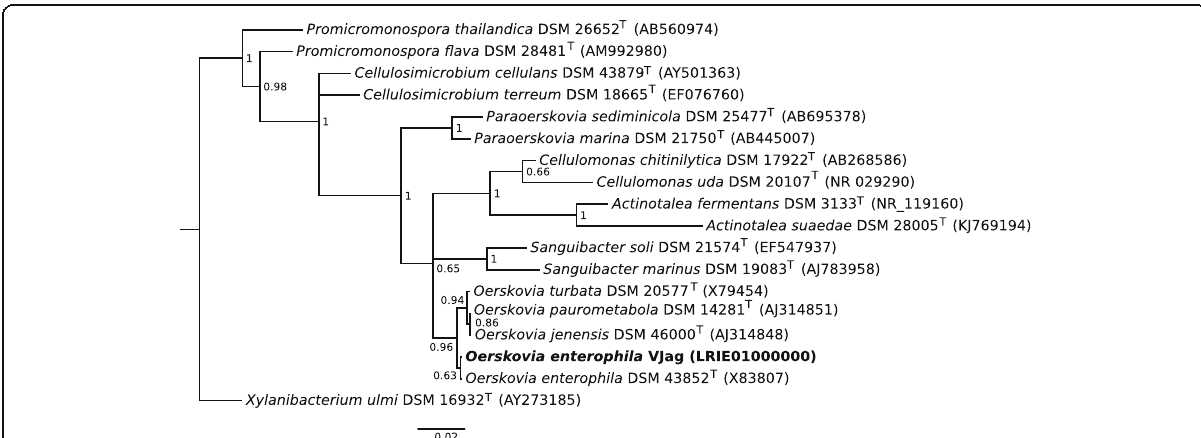
Fig. 2 Phylogenetic tree based on the 16S rRNA sequences indicating the genetic relationships between the isolate O. enterophila VJag and other closely related type strains. The scale bar shows 0.02 nucleotide changes per nucleotide position. The phylogenetic tree was created using